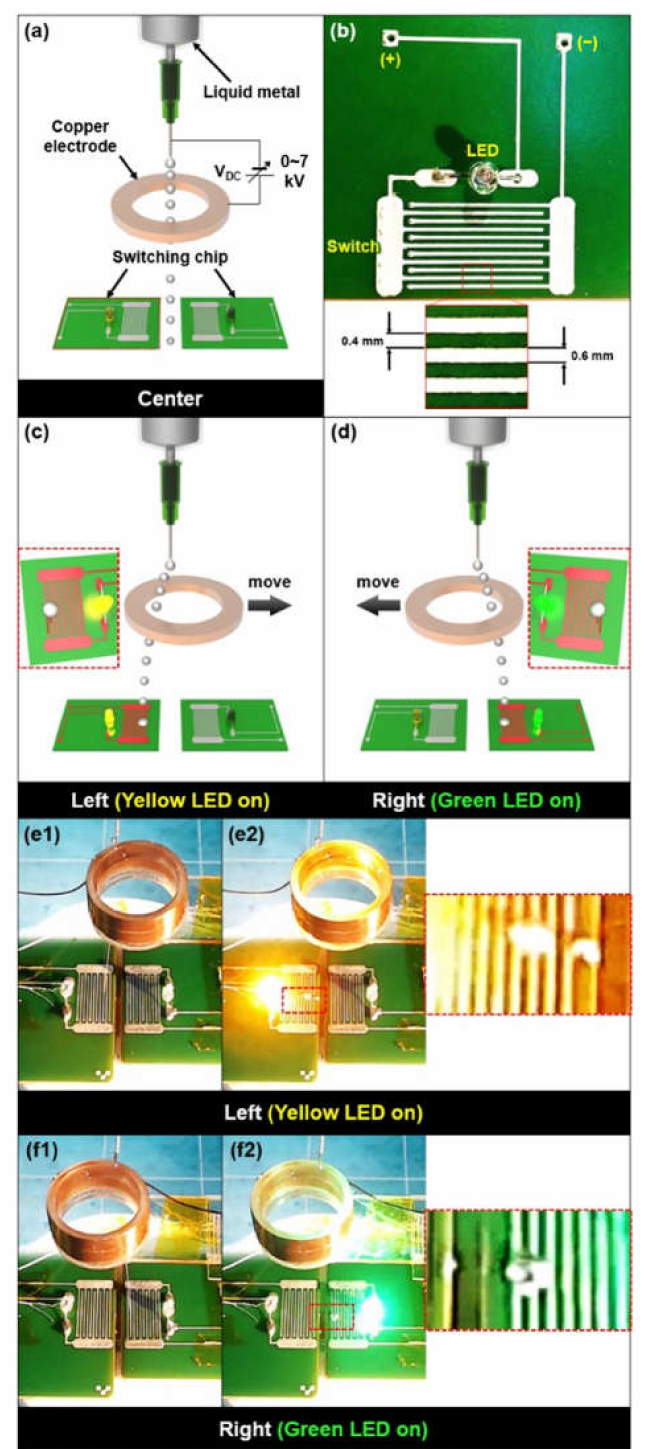
Figure 10. ( a , c , d ) Conceptual schematics and ( e , f ) optical images of short circuit demonstration using ( b ) an electrical circuit based on the falling direction control of a gallium-based liquid metal droplet depending on a position of a ring-shaped electrode (multimedia view): Yellow LED ( e1 ) off and ( e2 ) on by falling of liquid metal droplet on the electrical circuit; Green LED ( f1 ) off and ( f2 ) on by falling of liquid metal droplet on the electrical